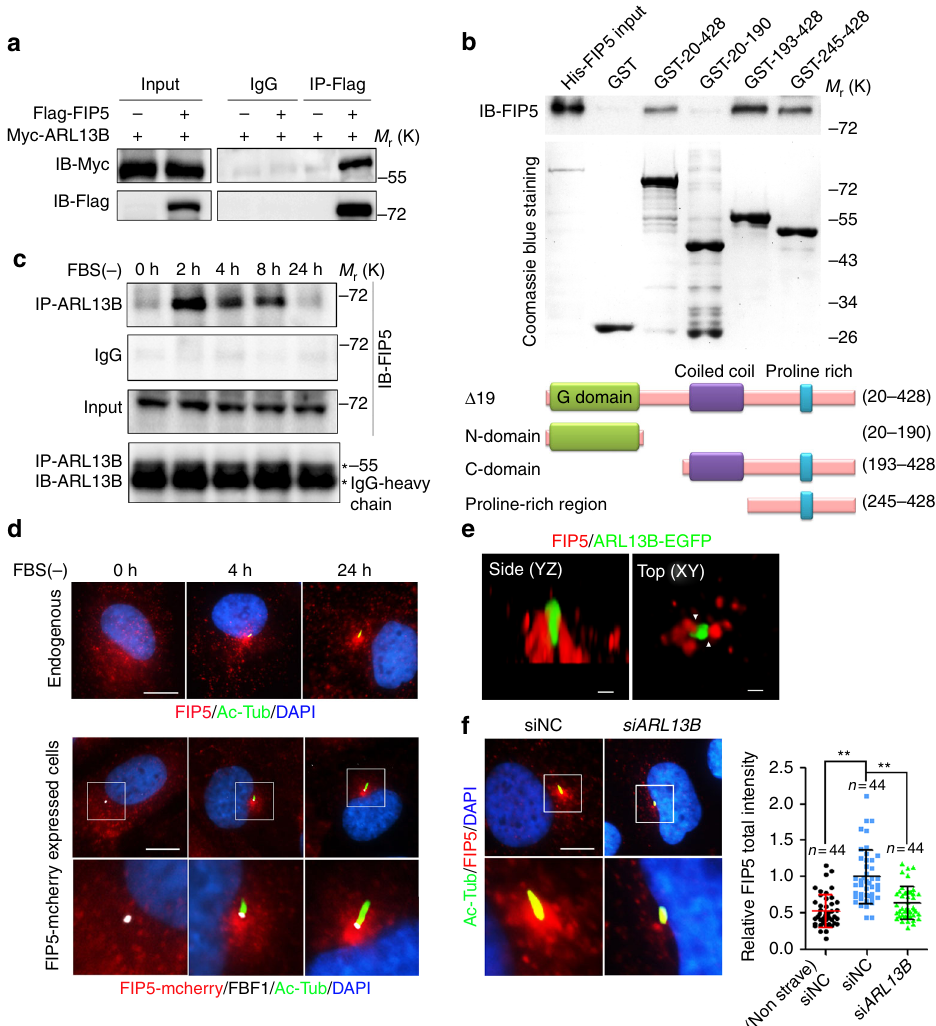
Fig. 1 ARL13B associates with FIP5 and regulates the latter ’ s enrichment at the ciliary base in a temporal-spatial manner. a Indicated plasmids were transfected in HEK-293T cells for 48 h and the interaction between exogenous FIP5 and ARL13B proteins was detected by immunoprecipitation. b Direct interaction between FIP5 and ARL13B was detected by GST pull-down assay. GST-fused WT Δ 19, N domain, C domain and Proline-rich region of ARL13B and His-FIP5 proteins were used. c In hTERT-RPE-1 cells, endogenous ARL13B strongly associates with FIP5 during the early stage of ciliogenesis but not in non-ciliated cells or the cells with mature cilia. d FIP5-positive vesicles speci fi cally translocate to the ciliary base during ciliogenesis. Endogenous FIP5 (upper), acetylated tubulin (Ac-Tub) and FBF1 were immunostained by corresponding antibodies and FIP5-mcherry (lower) was shown by direct fl uorescence. Ac-Tub was used as a ciliary marker and FBF1 was used as the transition fi ber marker. Scar bar: 10 μ m. e ARL13B-EGFP RCTE stable cells were serum starved for 2 h. Structure illumination microscopic study shows that FIP5-positive vesicles locate immediately adjacent to ARL13B signal at the ciliary base in a newly synthesized cilium. Endogenous FIP5 was immunostained by antibody and ARL13B-EGFP was shown by direct fl uorescence. Association of FIP5-positive vesicles and ARL13B were indicated by white triangles. Scar bars: 500 nm. f Depletion of ARL13B abolished the recruitment of FIP5-positive vesicles at the ciliary base in hTERT-RPE-1 cells. Quanti fi cation of FIP5 total intensity at mother centriole (non-ciliated cells) or cilia base (30 μ m 2 area were measured). Scar bar: 10 μ m. Center values represent mean. Error bars represent s.d. N values: cilia number accessed from at least six fi elds. Statistical signi fi cance was determined using unpaired Student ’ s t test. ** p < 0.01 Consistently, super-resolution structured illumination micro- Supplementary Fig. 1f). These data suggest that the ARL13B – FIP5 scopy showed that ARL13B-labeled compartment associates with association is likely of physiological signi fi cance during the FIP5-positive vesicles at cilia base 2 h after serum starvation, but early stage of ciliogenesis. not in mature cilia (24 h after serum starvation) (Fig. 1e; Supplementary Fig. 1e; Supplementary Movies 2, 3). Interestingly, FIP5 is required for axoneme polyglutamylation . To investigate in spite of the lack of FIP5-ARL13B interaction in mature cilia, FIP5-positive vesicles maintain their localization at cilia base the functional consequences of FIP5 depletion, we knocked down (Fig. 2d), indicating a possible ARL13B-independent localization FIP5 by speci fi c siRNAs in RCTE or human retinal pigment mechanism or low lateral diffusion for those vesicles. Of note, epithelium (RPE) cells (Supplementary Fig. 2a). We observed no upon ARL13B knockdown, FIP5 lost its enrichment around the defect on ciliogenesis or ARL13B localization in both cell types basal body without the decrease of total protein level (Fig. 1f; upon FIP5 depletion (Supplementary Fig. 2b, c; Fig. 2a). NATURE COMMUNICATIONS| (2018) 9:3310 |DOI: